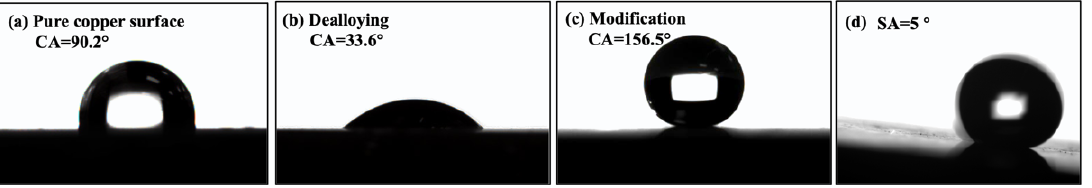
Figure 7. Contact angles of the prepared surface: ( a ) original copper surface; ( b ) dealloyed surface; ( c ) modified surface; ( d ) the water droplet rolling down the superhydrophobic surface and its sliding angle.